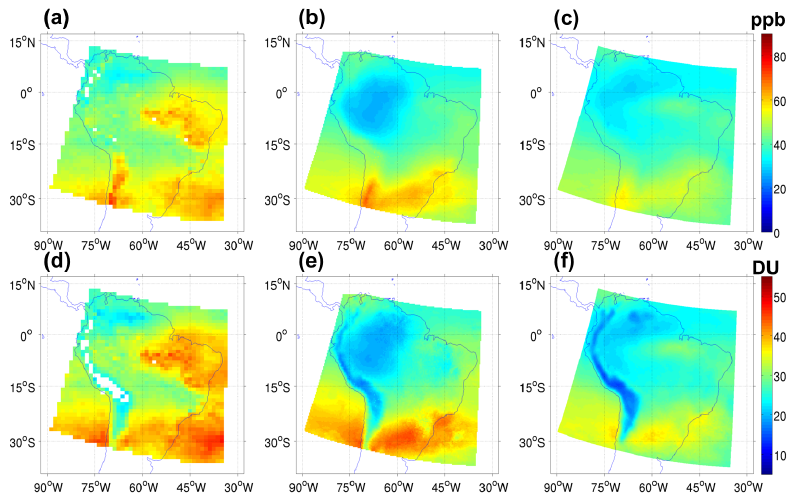
Figure 20. Mean tropospheric O 3 (ppb) on the 35km domain from (a) OMI/MLS, (b) CCATT-BRAMS and (c) WRF-Chem and total tropospheric column O 3 (Dobson units) from (d) OMI/MLS, (e) CCATT-BRAMS and (f) WRF-Chem for November